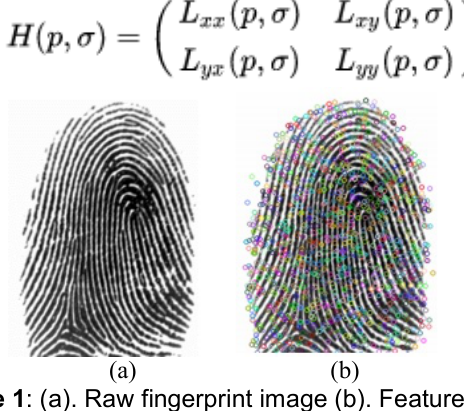
Figure 1 : (a). Raw fingerprint image (b). Features extracted using